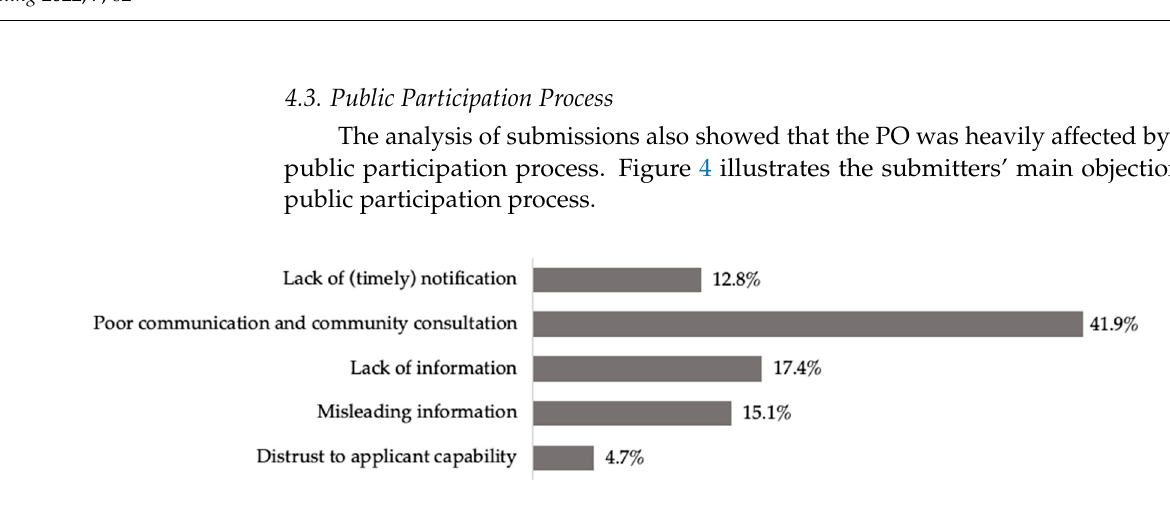
Figure 4. Submitters’ main objections to the public participation process. Source: authors.